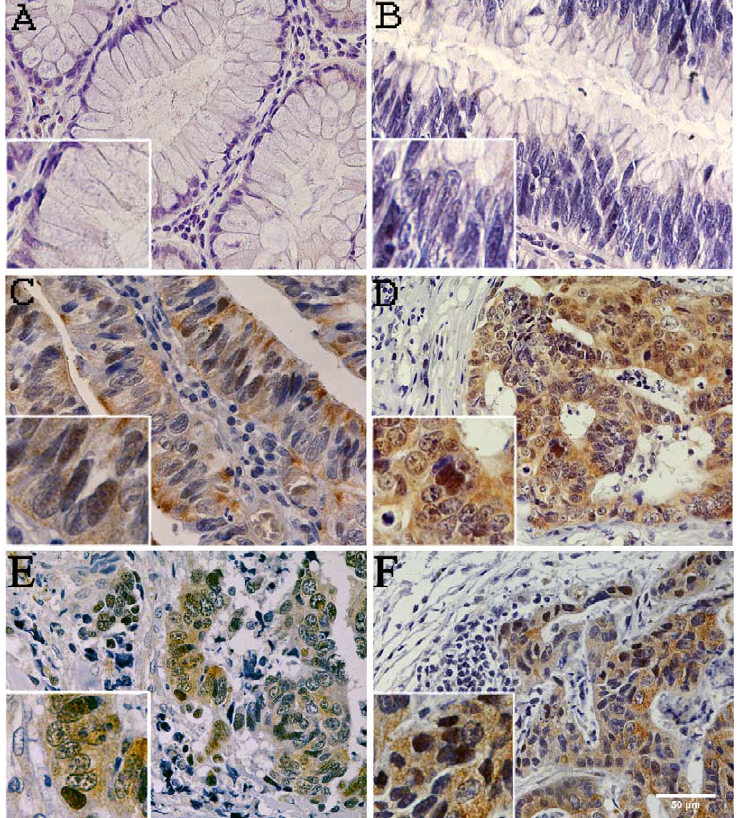
Fig. 1. SnoN expression in human colorectal cancer. (A) Normal colon mucosa with negative SnoN expression. (B) Negative SnoN staining in an adenoma with mild dysplasia. (C) Adenoma with high grade dysplasia showing cytoplasmic and nuclear immunoreactivity of SnoN. (D) Strong cytoplasmic and nuclear SnoN expression in an invasive carcinoma. (E, F) Representative cases of a primary tumor (E) and corresponding lymph node metastases (F) showing similar cytoplasmic and nuclear expression levels of SnoN (400 × magnification). Inserts in lower left corner show the subcellular localization of immunostaining in each case at higher magnification (2 × original objects). Bar corresponds to 50